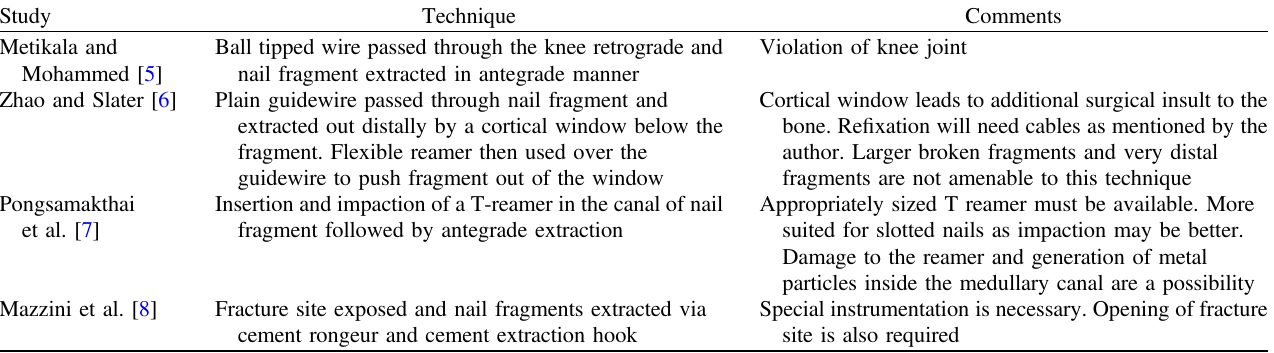
Table 1. Techniques of removing broken